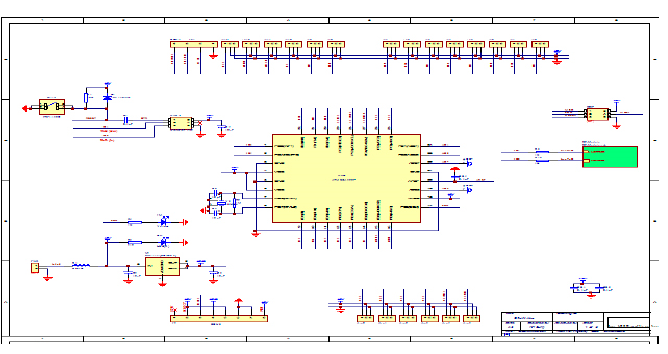
Figure 9. General typical RF structure. Appl. Sci. 2020 , 10 , x FOR PEER REVIEW